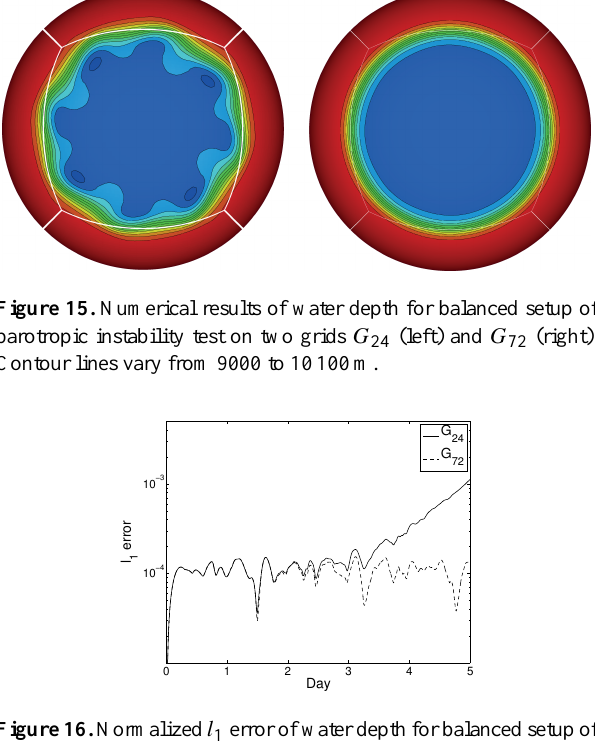
Figure 16. Normalized l 1 error of water depth for balanced setup of barotropic instability test on two grids.